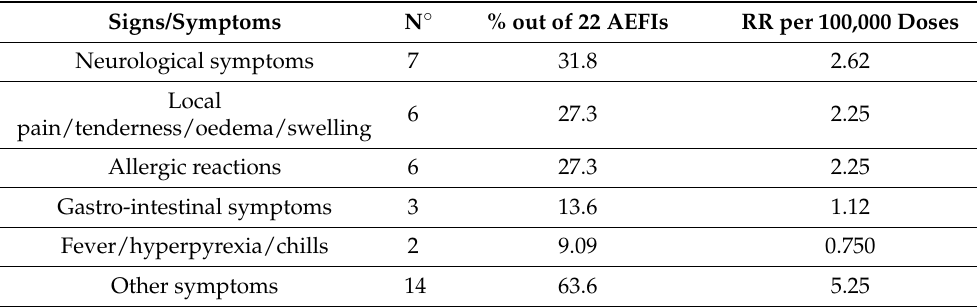
Table 2. Prevalence of specific signs and symptoms described in the AEFI reports, and reporting rates (RR) per 100,000